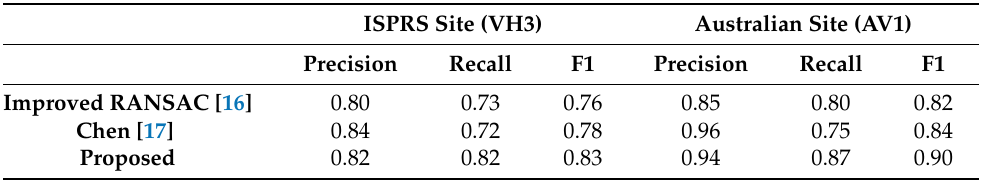
Table 6. Quantitative comparison of the extracted boundary points.